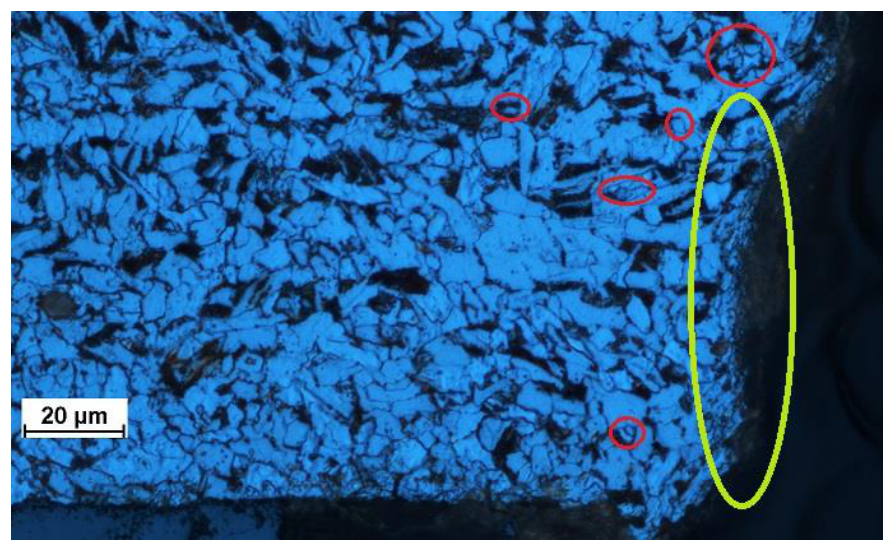
Figure 9. Recrystallization (red circles and yellow circles—at the cutting edge) in the microstructure of a metallographic specimen.